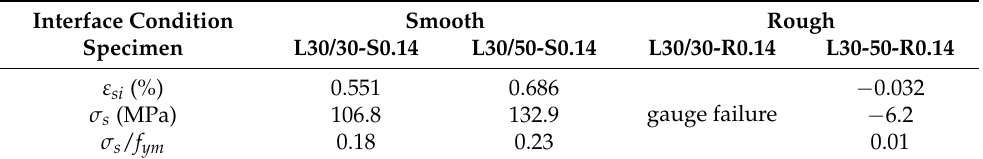
Figure 14a. The failure resembled in a way the "unsticking" of the block made of LWAC, because the polished surface of the substrate was exposed. The compressive strength of the substrate concrete was in this case by over 20% higher than that of LWAC overlay. When considering the tensile strength, the difference was even higher and exceeded 40%, which resulted in a limited specific adhesion. Taking into account the low mechanical adhesion resulting from the surface preparation method (soft grinding), it was a natural thing that failure occurred within LWAC